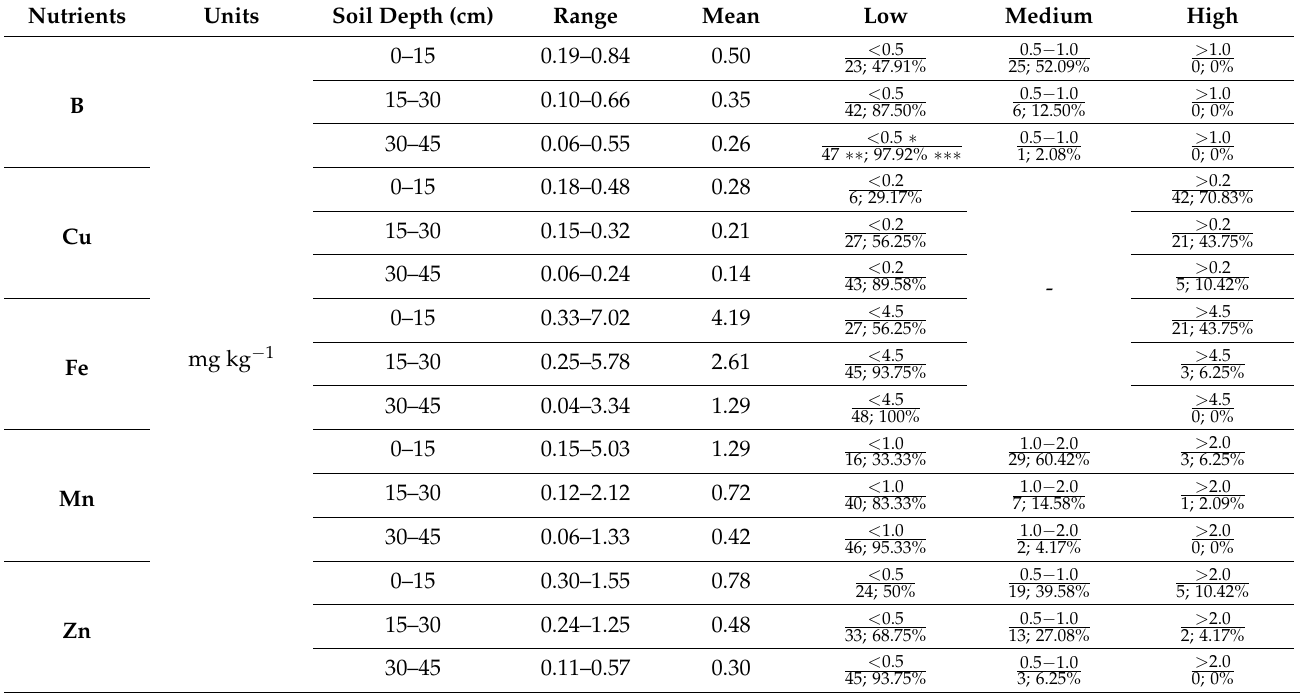
Table 4. Summary of data showing micronutrients (mg kg − 1 ) status of citrus orchards in Layyah district. There were 48 sites at which sampling was performed. Means are an average of 3